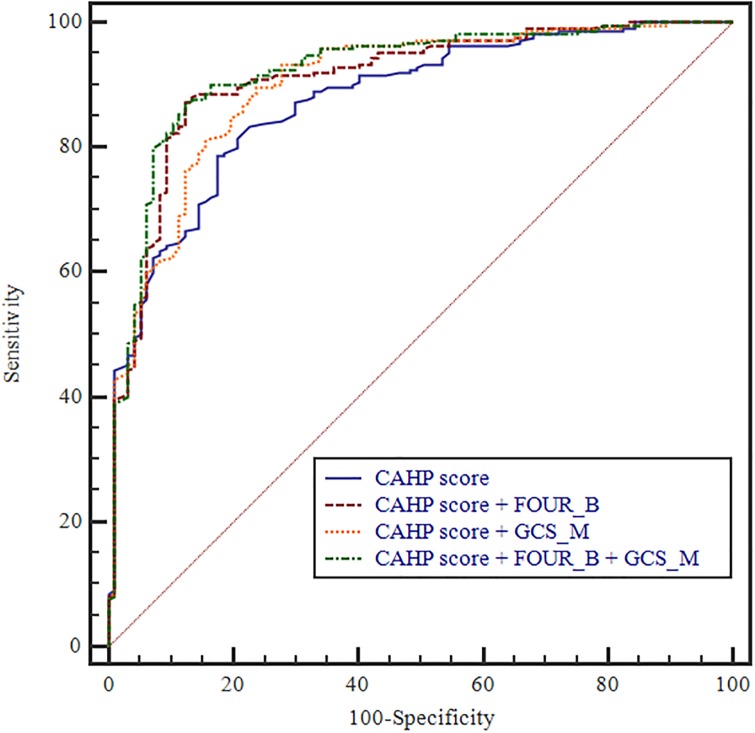
Prognostic value of CAHP score for the prediction of poor neurologic outcome after CA.[1] CAHP score (AUC 0.872, 95% CI 0.830–0.907); [2] CAHP score with FOUR_B (AUC 0.901, 95% CI 0.862–0.932); [3] CAHP score with GCS_M (AUC 0.897, 95% CI 0.858–0.929); [4] CAHP score with FOUR_B and GCS_M (AUC 0.913, 95% CI 0.875–0.942).